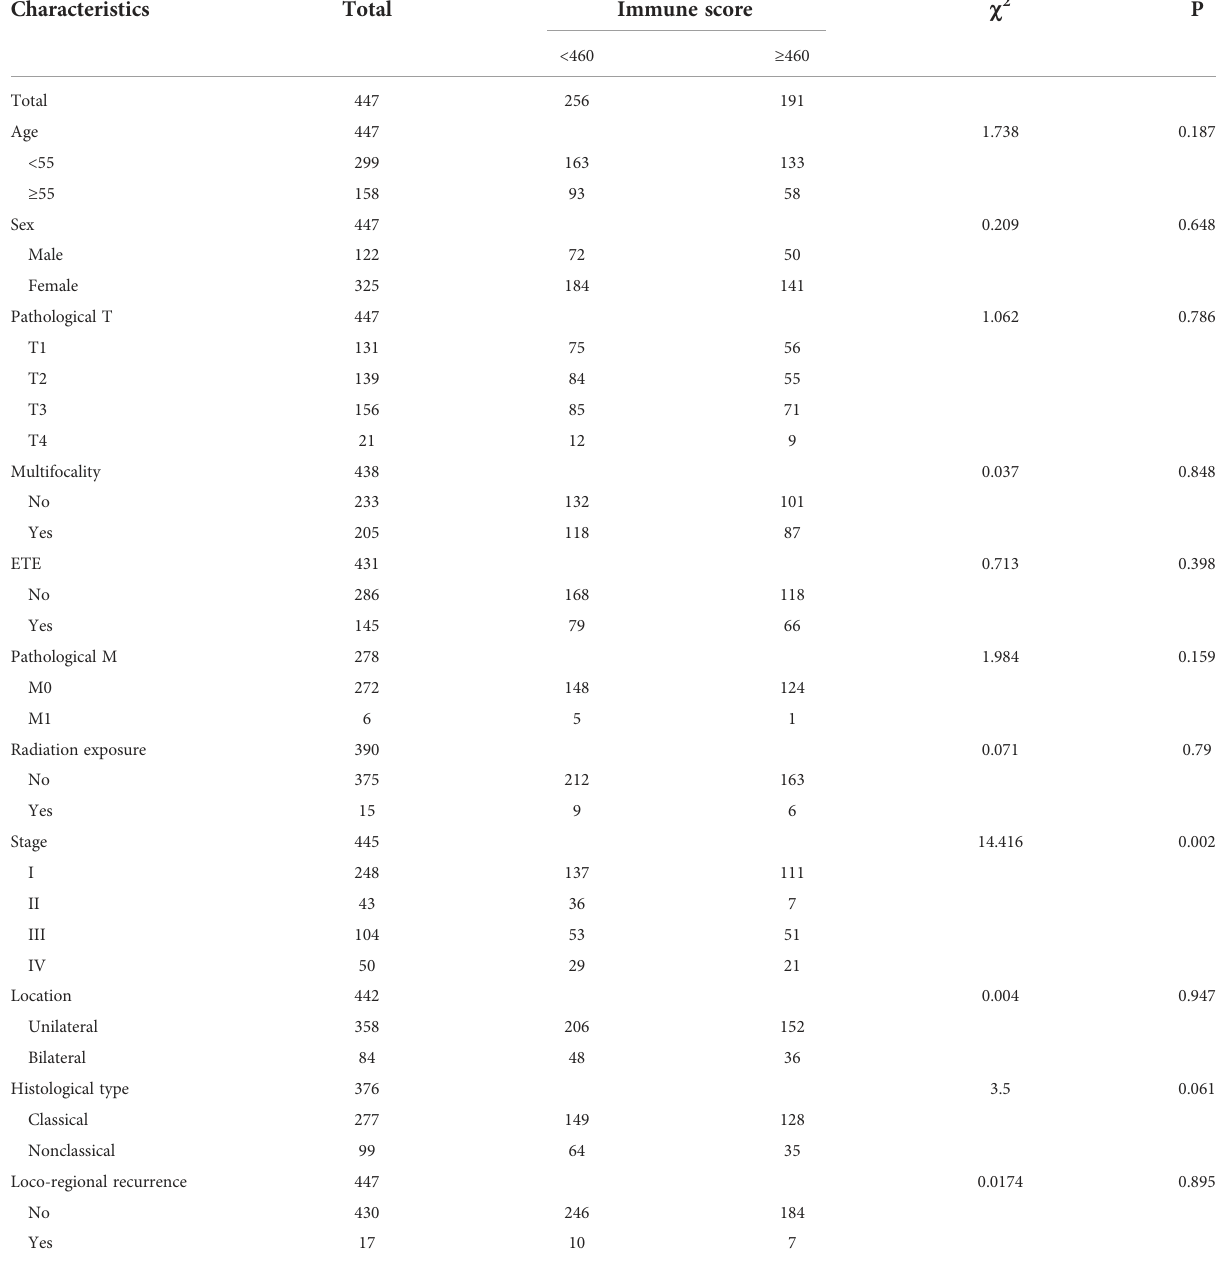
TABLE 1 Associations between clinical-pathological characteristics and immune